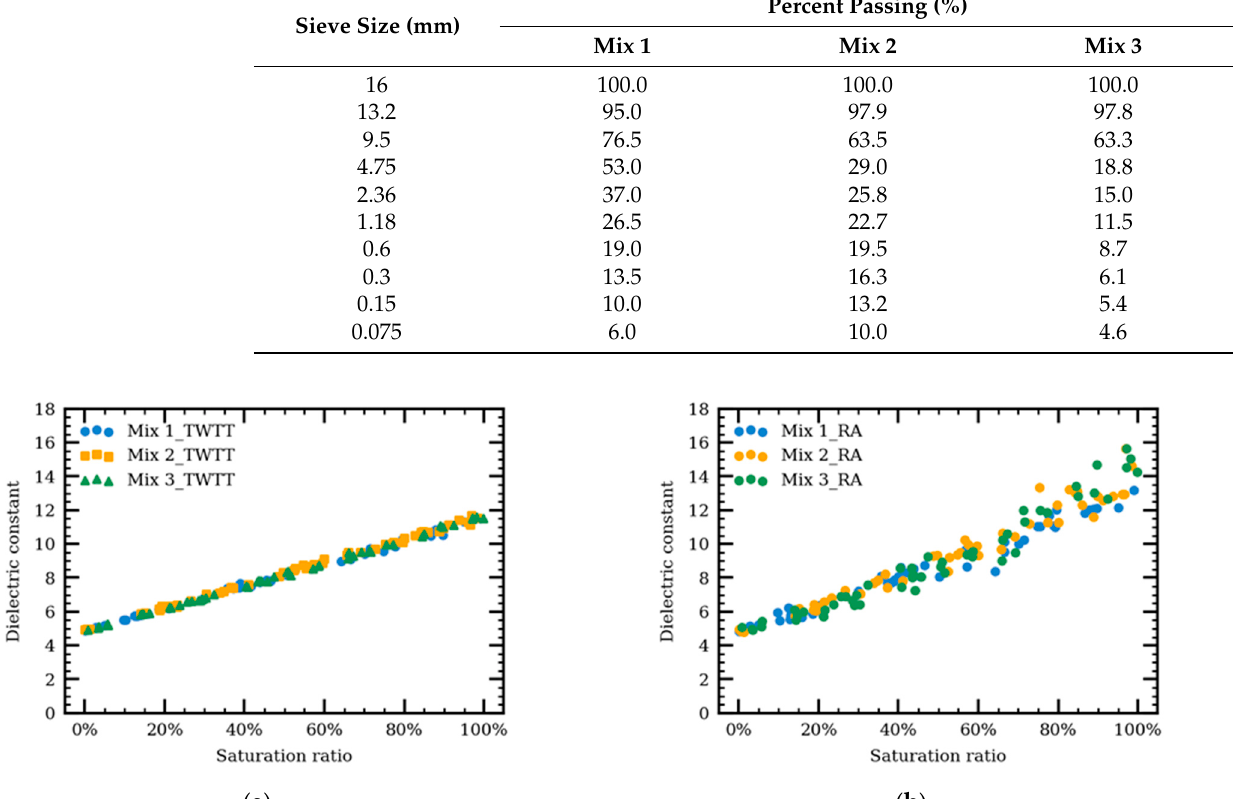
Table 3. Aggregate gradation of three AC mixtures.